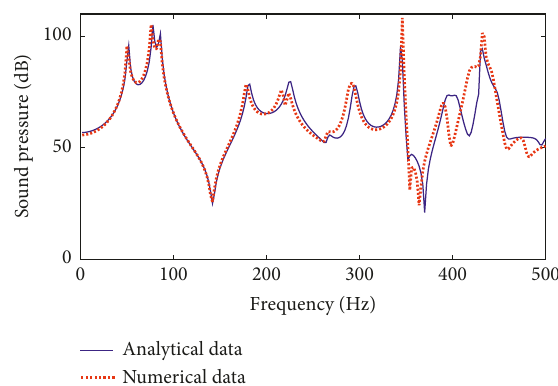
Figure 7: Vibration velocity response at the position ( x y � 0.1m) on the surface of panel 2. 2